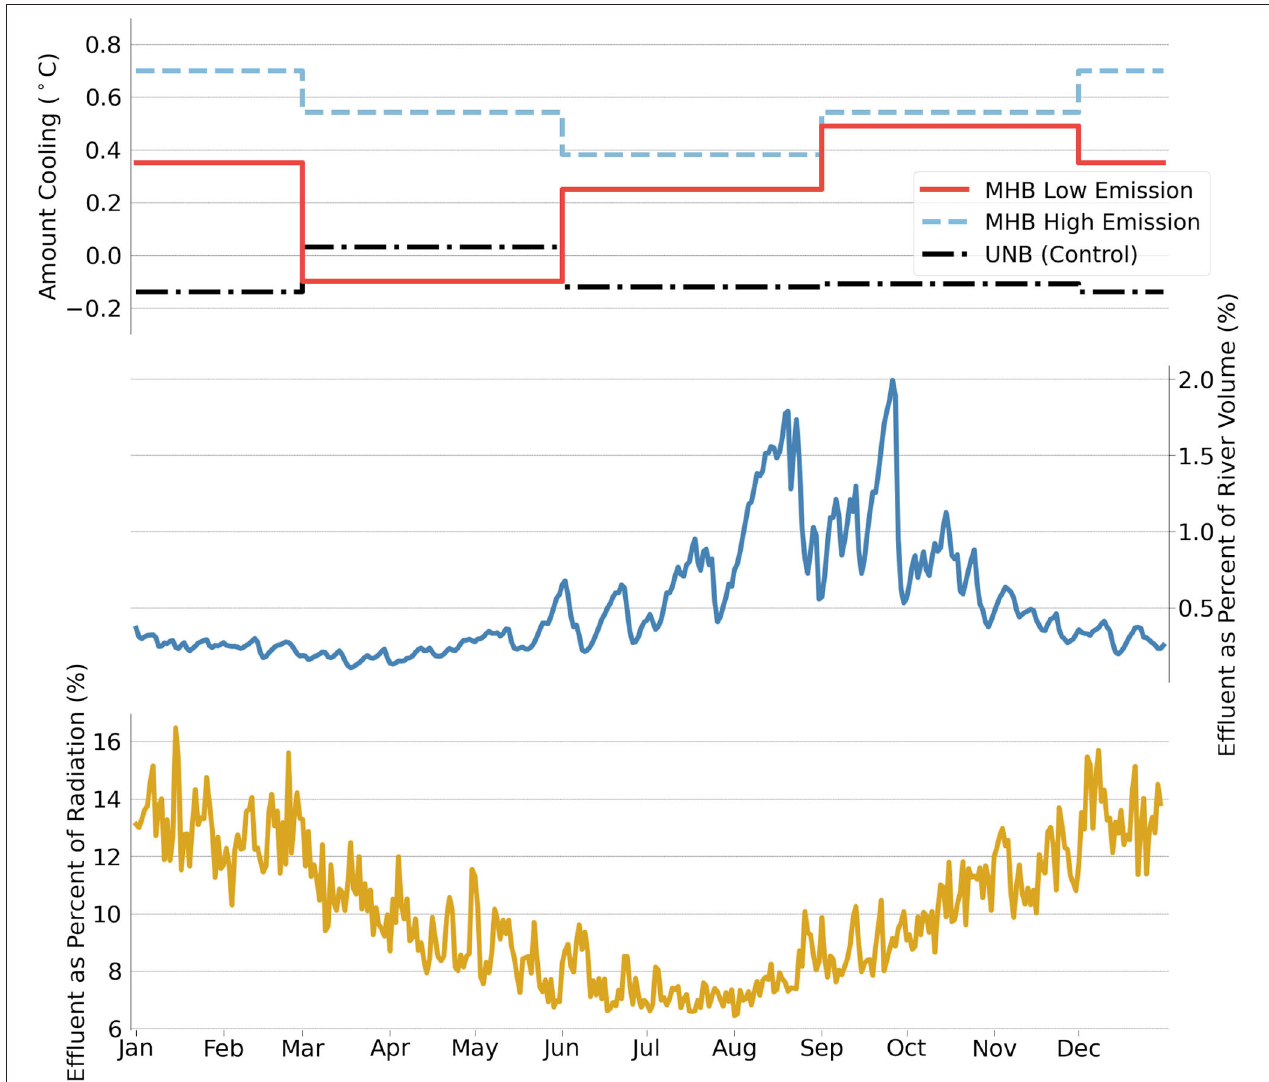
FIGURE 10 | BPPS effluent volume and heat as a percent of river volume and total longwave plus shortwave radiation, respectively, plotted below the seasonal differences in the amount of cooling observed in Mt. Hope Bay (MHB) and Upper Narragansett Bay (UNB) as recorded in Table 2 . to what was previously only seen in Mt. Hope Bay.